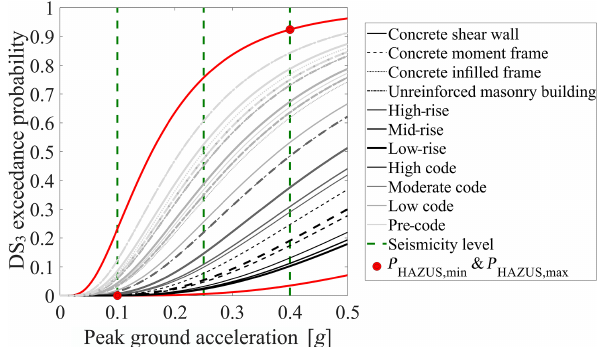
Figure 3. HAZUS fragility curve database related to DS 3 (extensive damage state) for RC and URM